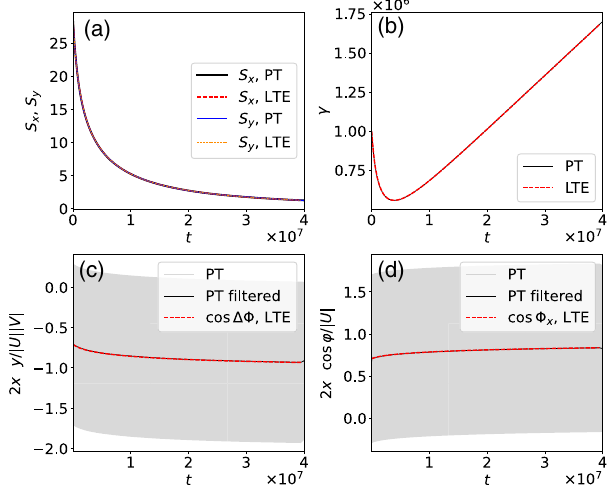
FIG. 2. The numerical comparison of the LTEs and the original equations solved by PTracker in the transition between the betatron phase shift dominant and the RR dominant regimes. (a) S x þ S y is initially approximately a constant but decreases later. (b) γ increases due to the acceleration field and passes the regime transition at γ ¼ ð k p r e Þ − 2 = 5 ¼ 10 4 . (c) and (d) show the same treatments as in Figs. 1(c) and